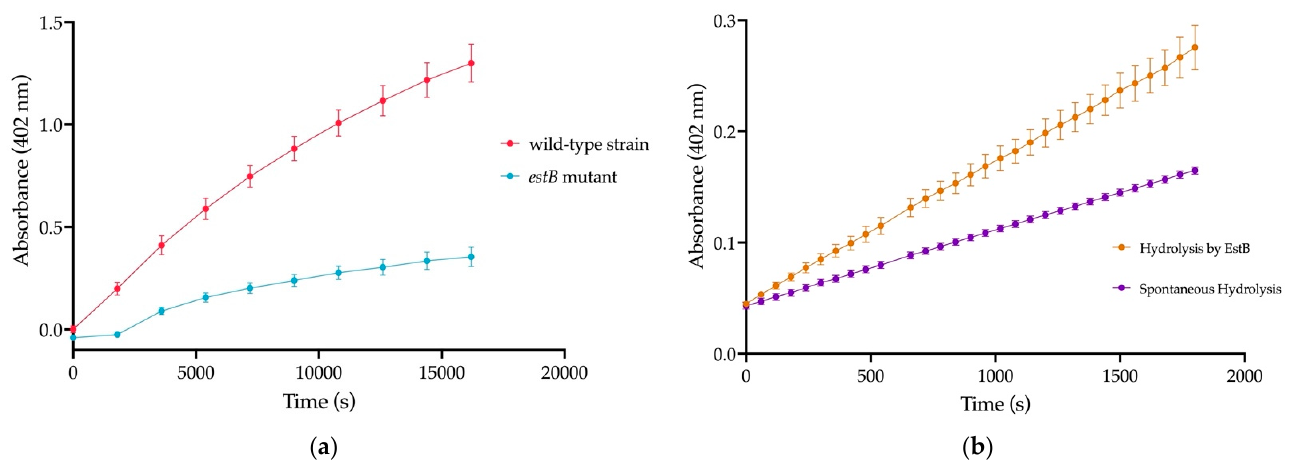
Figure 2. 4-Nitrophenyl Butyrate (p-np butyrate) Assay to determine esterase activity ( a ) Deletion of estB resulted in significant decrease in activity against np-butyrate indicating loss of esterase activity; ( b ) Purified EstB resulted in significant hydrolysis of np-butyrate, indicating this protein possesses esterase activity.